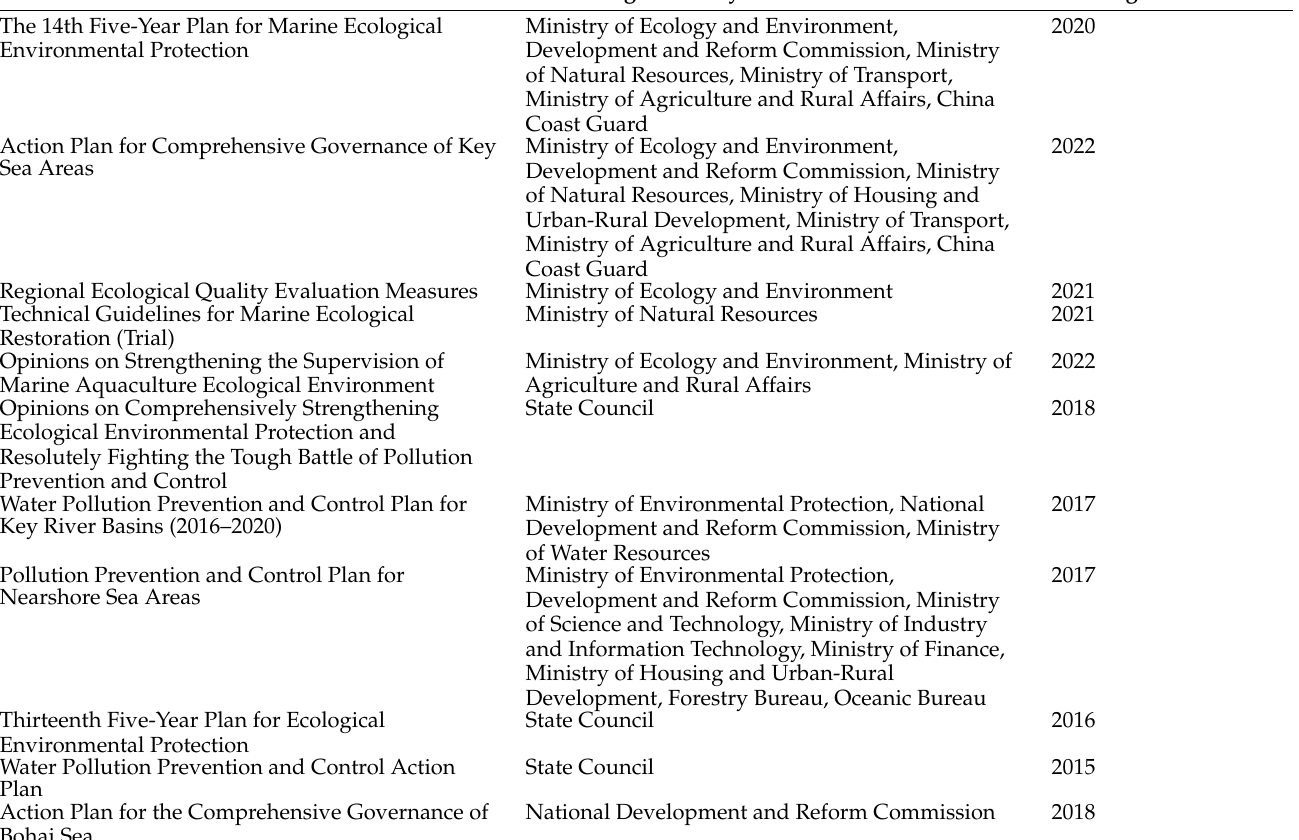
Table 3. Environmental policies and plans related to oceans in